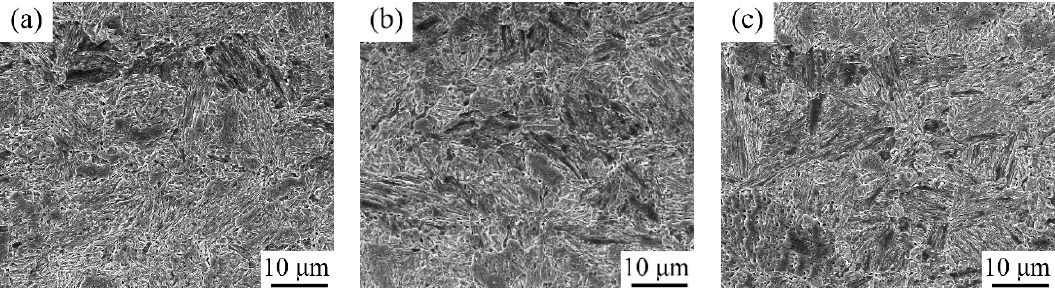
Figure 6. SEM images after being tempered at 200 °C: ( a ) IA-6 h; ( b ) IA-12 h; and ( c ) IA-50 h.